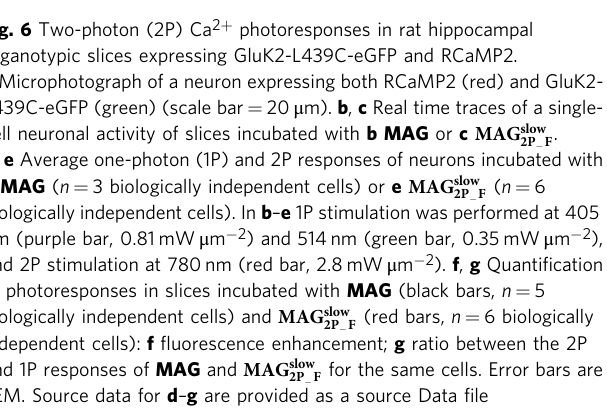
Fig. 6 Two-photon (2P) Ca 2 + photoresponses in rat hippocampal organotypic slices expressing GluK2-L439C-eGFP and RCaMP2. a Microphotograph of a neuron expressing both RCaMP2 (red) and GluK2- L439C-eGFP (green) (scale bar = 20 μ m). b , c Real time traces of a